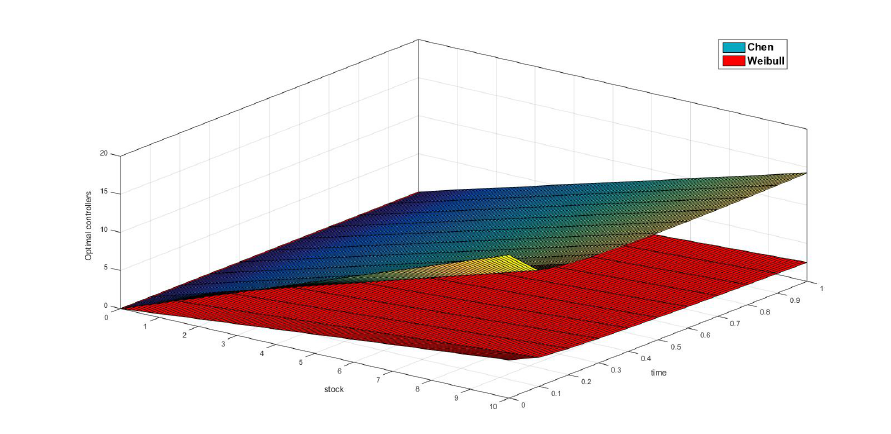
Figure 11. Optimal Weibull (red) and Chen (blue) controllers when δ 1 = 1 ( t , x ) ∈ [ 0,1 ] × [ 0,10 ]